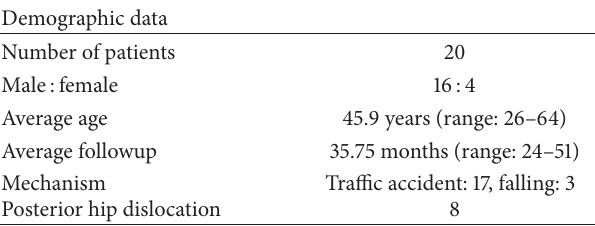
Table 1: Demographic data of the